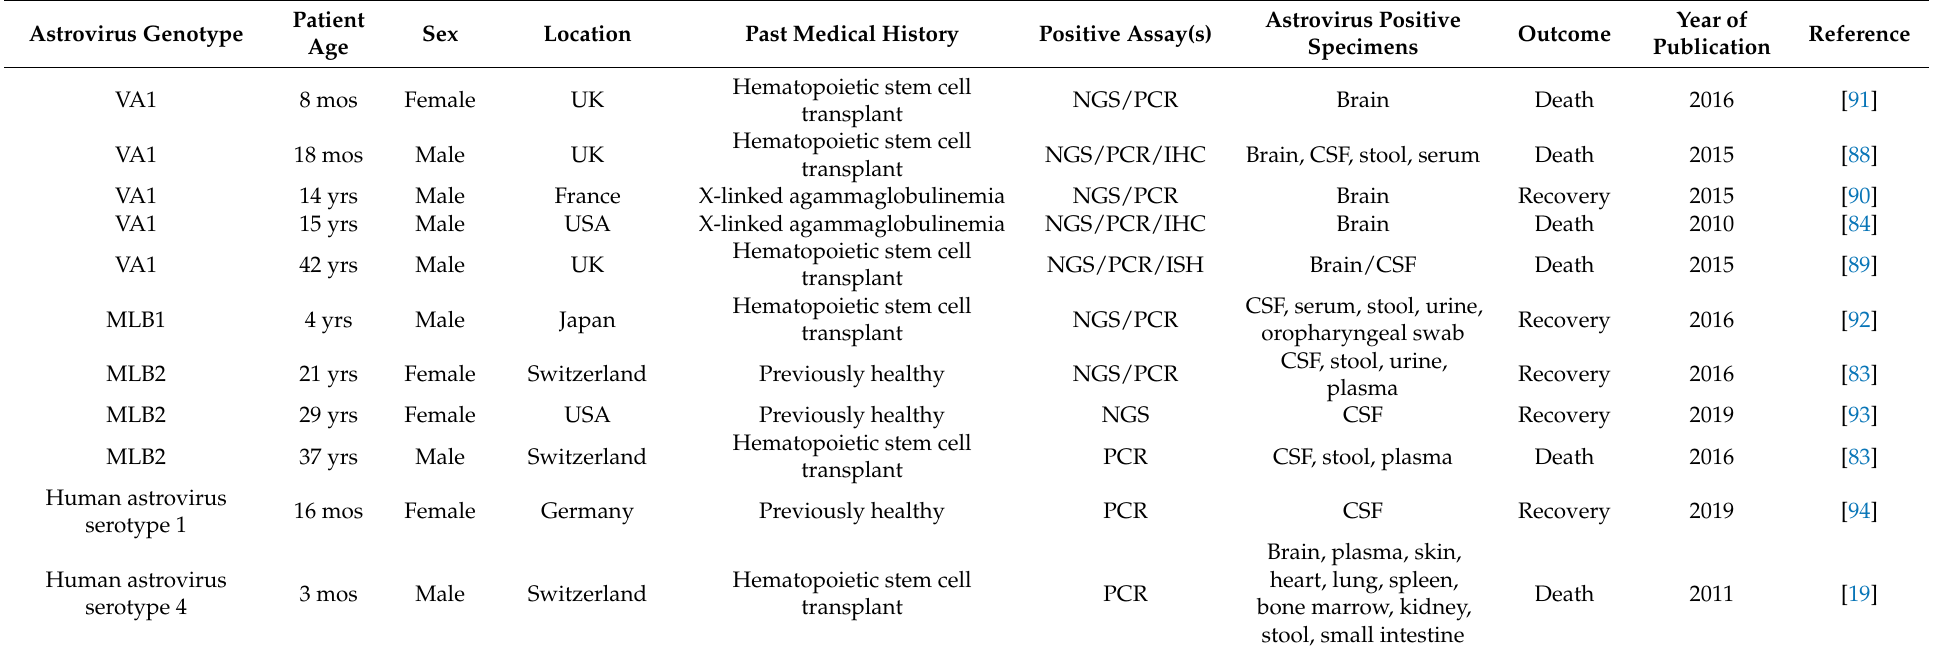
Table 1. Descriptions of the published cases of neuroinvasive disease in humans caused by